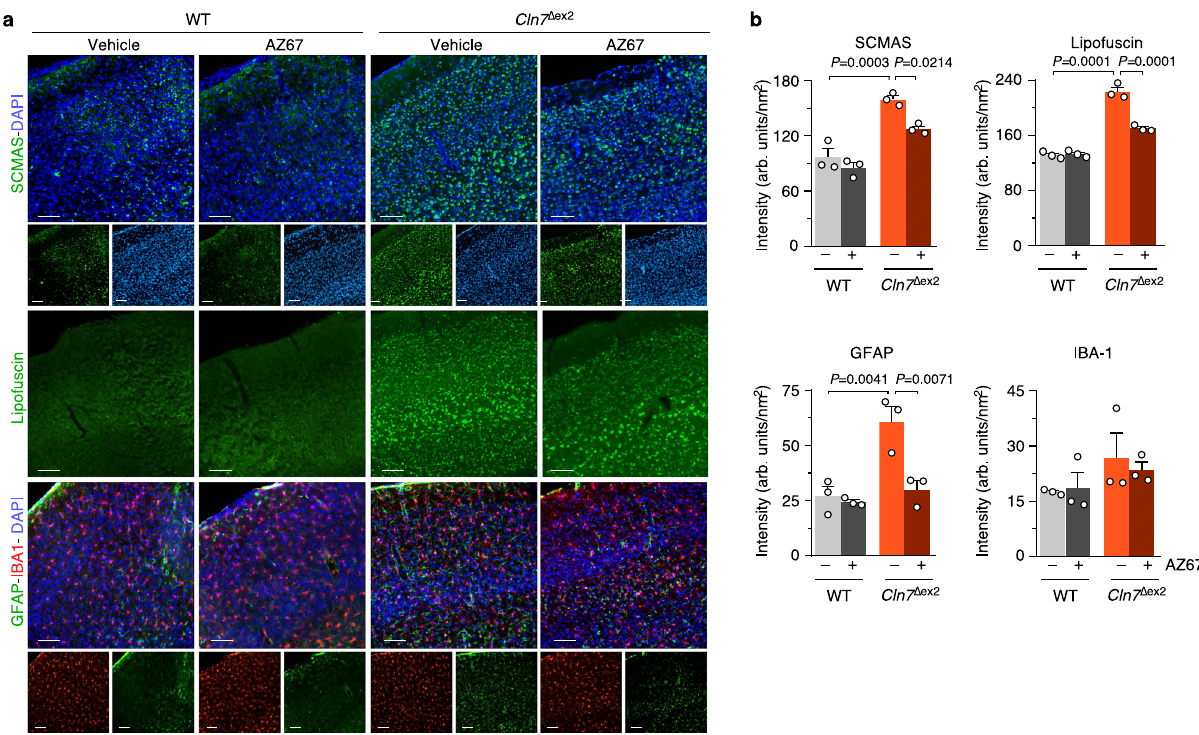
Fig. 5 Pharmacological targeting PFKFB3 restores hallmarks of Cln7 Δ ex2 disease in vivo. a Representative images of SCMAS, lipofuscin, GFAP, and IBA-1 immunohistochemical analysis of the mouse brain cortex after 2 months of a daily intracerebroventricular administration of PFKFB3 inhibitor AZ67 (1 nmol/mouse). b Quanti fi cation of the images shown in panel a. Data are mean ± SEM from n = 3 animals of 5-month old (three serial slices per mouse). Scale bar, 100 µ m. Statistical analyses performed by one-way ANOVA followed by Tukey ’ s post hoc test. See also Supplementary Figs. 4 and 5. Source data are provided as a Source Data fi